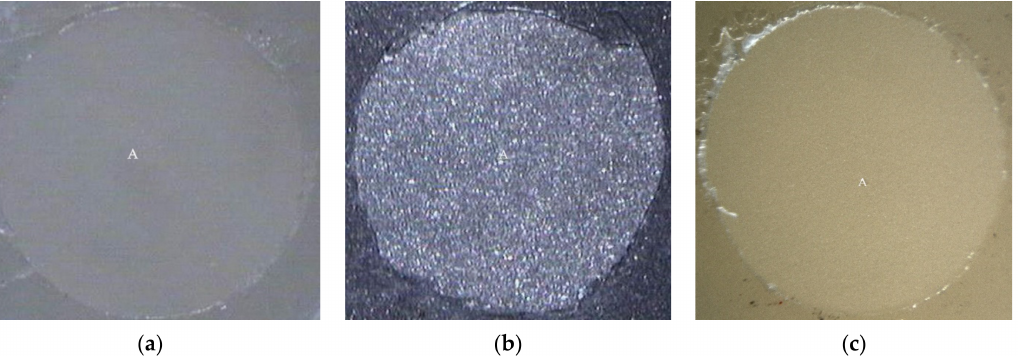
Figure 3. Mixed failure of cohesive in resin (R) and adhesive at resin-PMMA rod interface (R/PMMA) on fractured specimens of ( a ) experimental biopolymer, ( b ) resin composite, and ( c ) metal alloy, using Super-Bond C&B (original 20 × ).